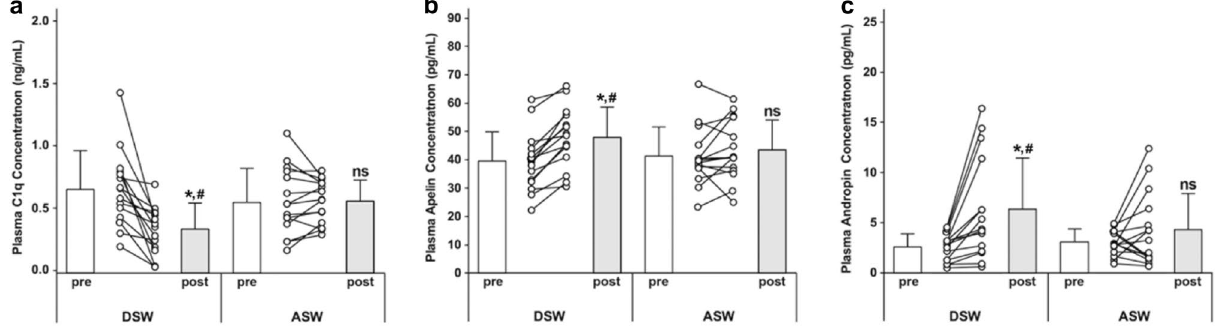
Figure 1. Changes (individuals, mean ± SD) in plasma complement component 1q (C1q) ( a ), apelin ( b ) and adropin ( c ) concentrations before (pre) and after (post) 12 weeks of descending (DSW) and ascending stair walking (ASW) interventions. *Significant change ( p ≤ 0.05) compared to the baseline (pre) level in each group; ns: no significant difference ( p ≥ 0.05) from the baseline (pre) level; # Significant difference ( p ≤ 0.05) compared to the post-intervention level in the ASW